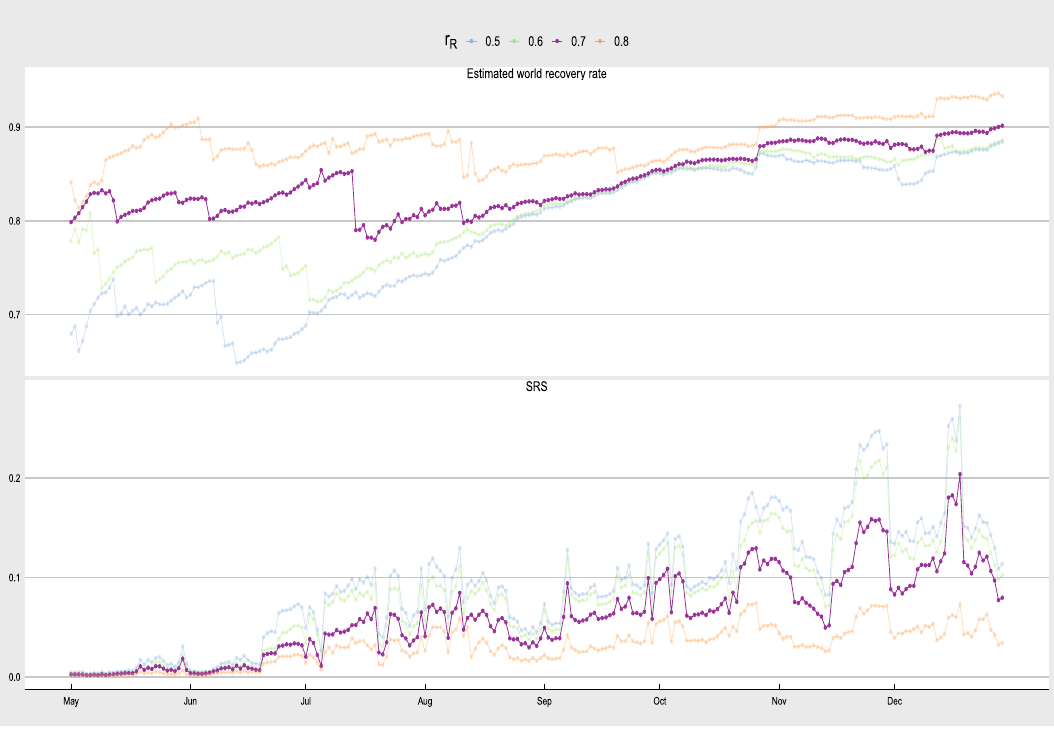
Figure 8. The top panel shows the estimated world recovery rate based on r R = 0.5 to 0.8. The bottom panel shows the SRS based on the imputed number of recovered cases with r R = 0.5 to